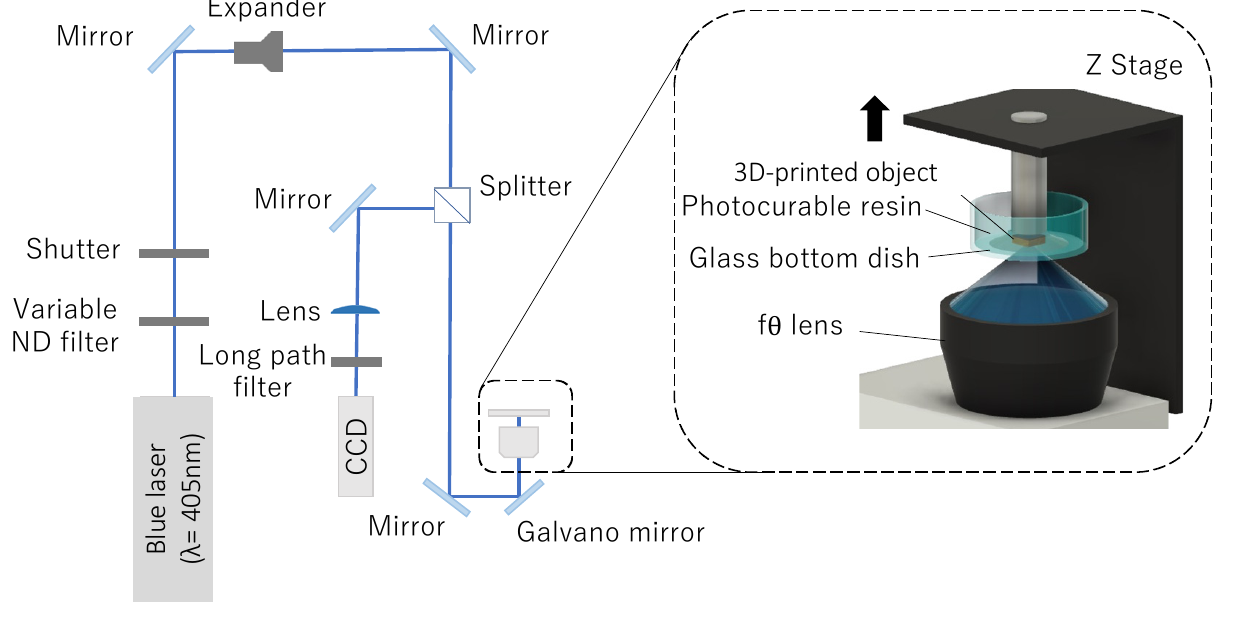
Figure 2. Schematic of the bottom-up stereolithography system using a blue laser.